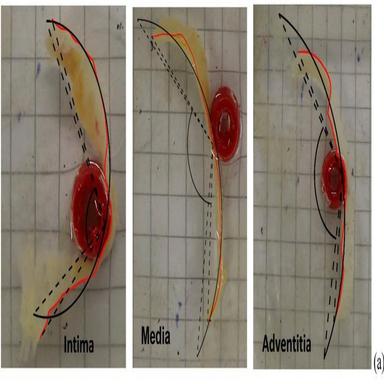
Procedure for the measurement of residual circumferential stresses. Strip profile obtained from digitized points from photo and corresponding fitting circle; definition of the opening angle α and the curvature radius r. (a) Stress-free configurations for the circumferential strips from donor III. (b) tunica media from donor II showing a very large opening angle α = 457°.